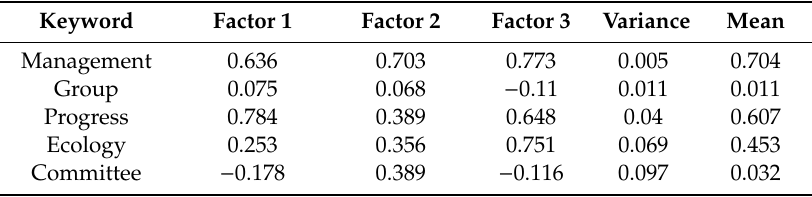
Table 4. Extraction of commonly recognized keywords with a variance ≤